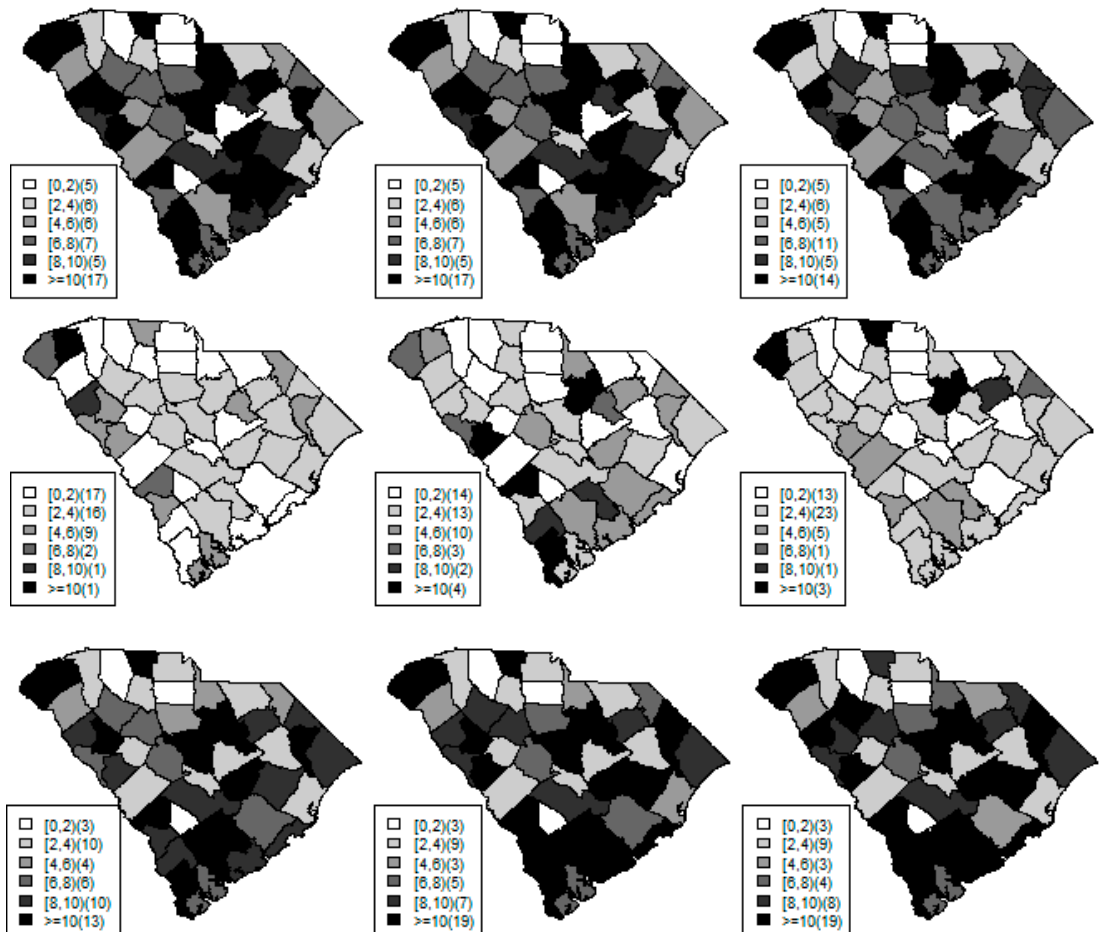
Figure 1. Maps of the estimated 90th quantile relative risks from the proposed quantile ( top row) and mean ( middle row) regression models versus the simulated relative risks ( bottom row) during years 2 (left) to 4